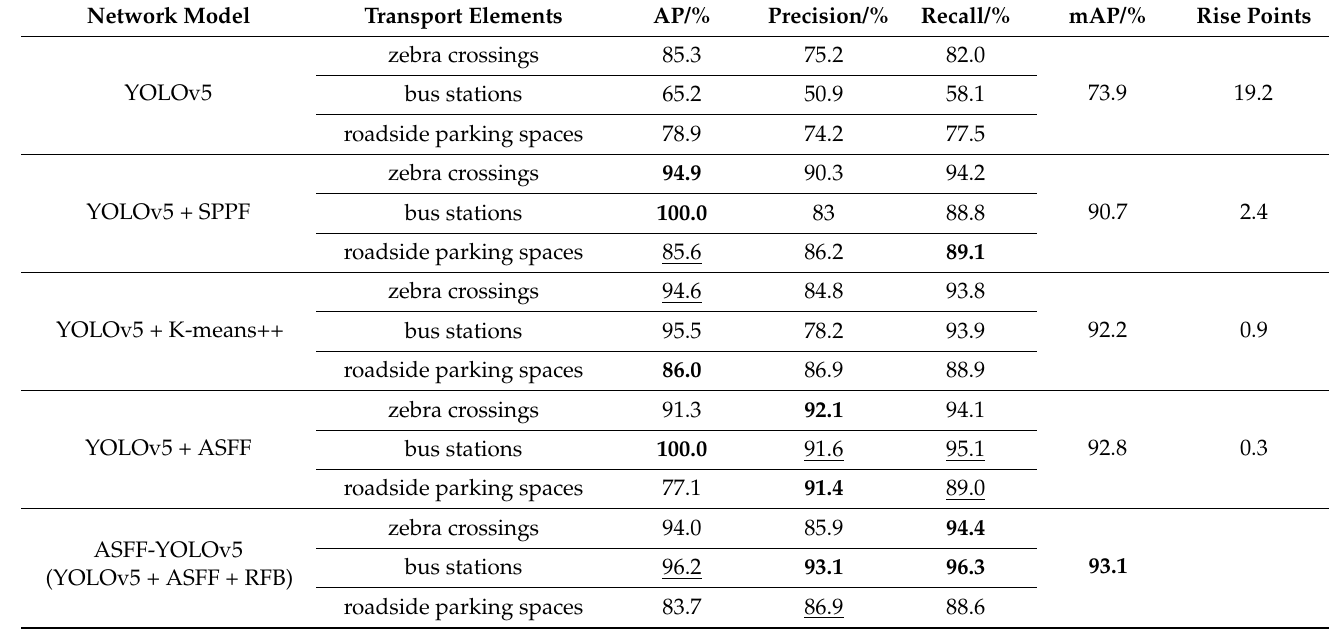
Table 5. Results of ablation